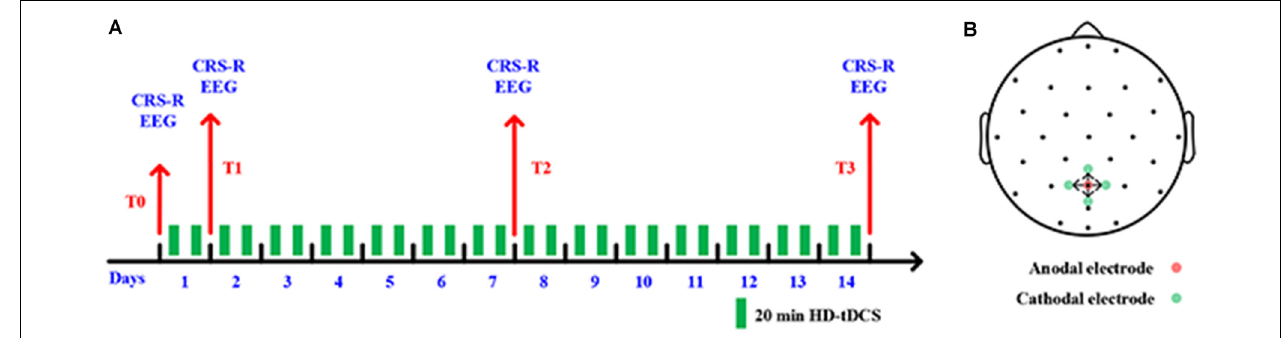
FIGURE 1 | (A) Outline of the experimental design. (B) Positions of electrodes for high-definition transcranial direct-current stimulation